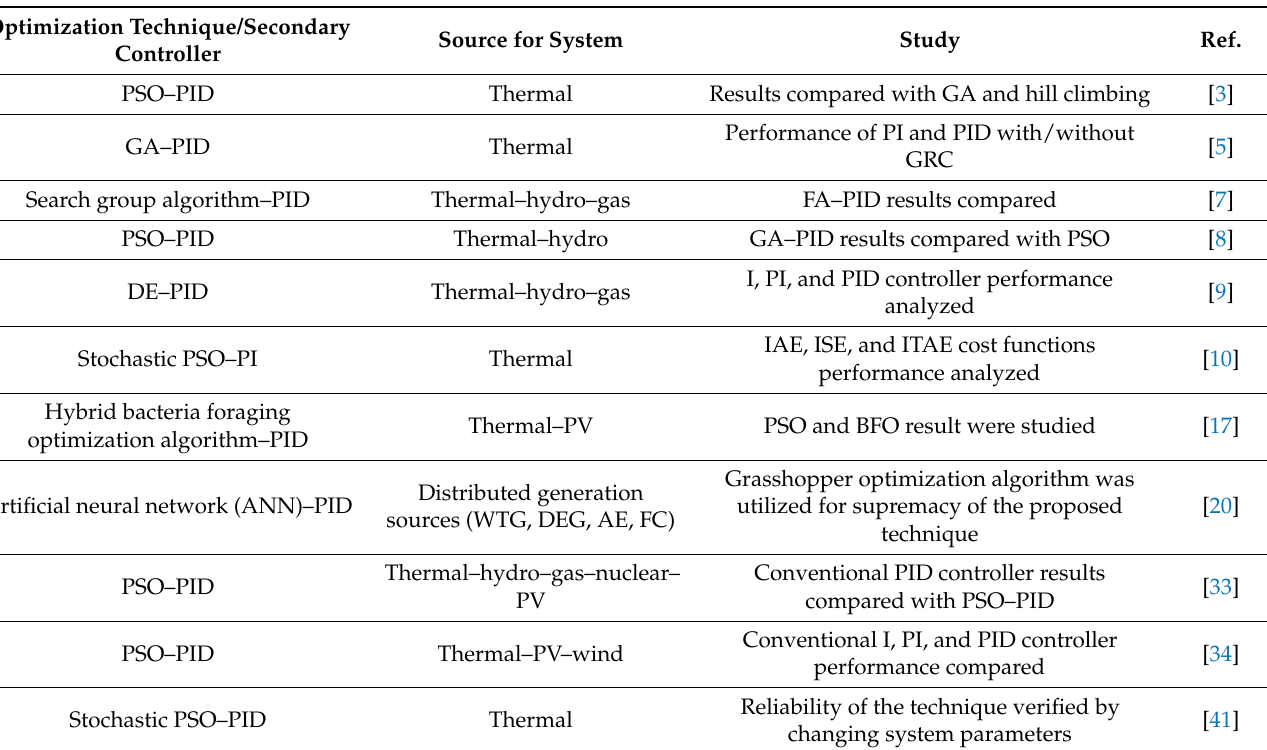
Table 1. Summary of the literature